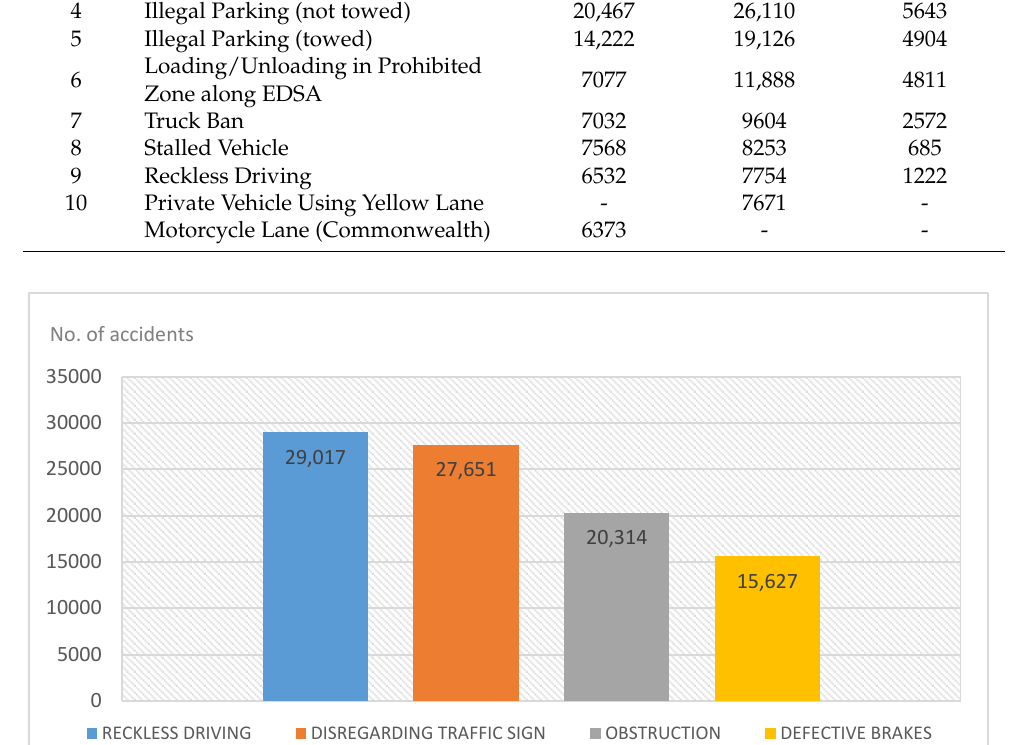
Figure 1. Major causes of vehicular accidents in Metro Manila, 2017.